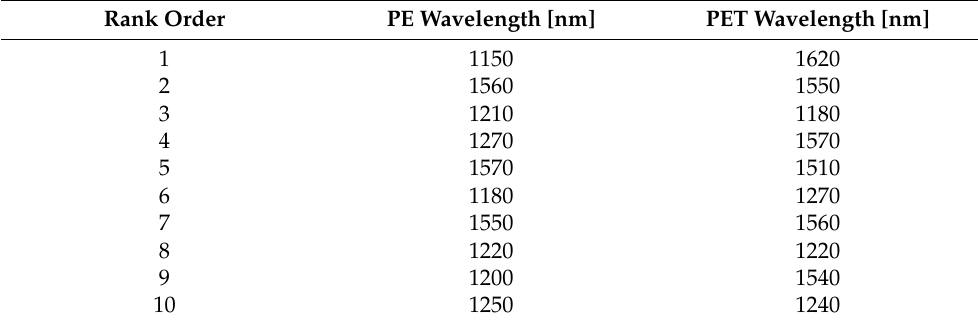
Table 1. Most relevant wavelengths chosen automatically for polymer